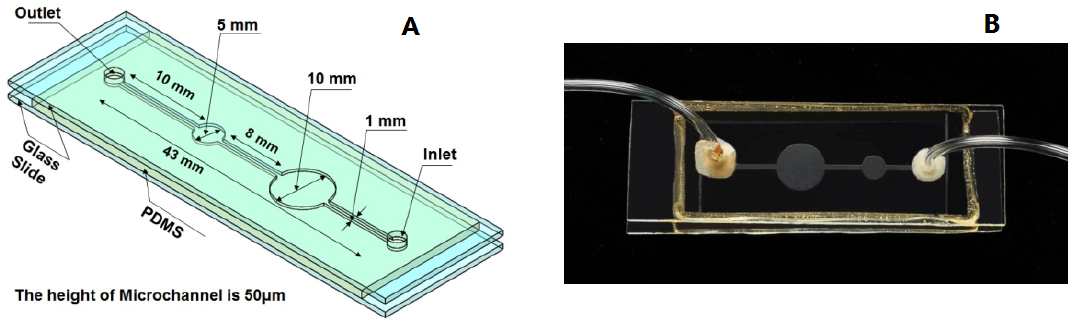
Figure 1. Schematic and photography of the microfluidic device. ( A ) Schematic of the microfluidic device; ( B ) photography of the microfluidic device.